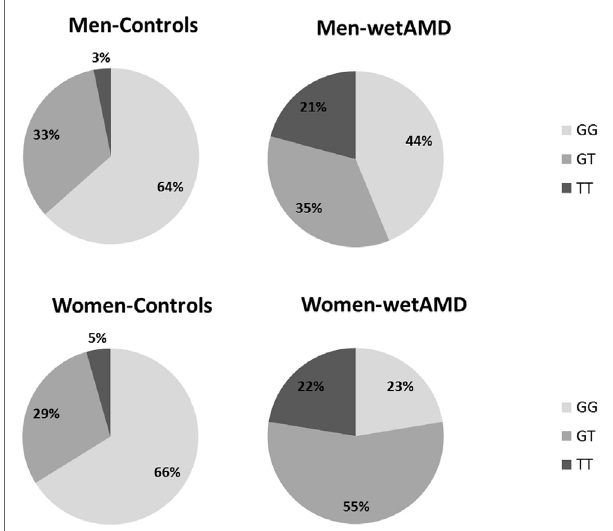
FigUre 1 | Percentage of individuals according to C-reactive protein (CRP) level stratification divided by gender (men: upper row; women: lower row) and study groups (controls: left column and wet age-related macular degeneration: right column). L-CRP (low C-reactive protein, < 1 mg/L; light gray), M-CRP (moderate C-reactive protein, 1.0–3.0 mg/L; medium gray), and H-CRP (high C-reactive protein, 3.0–10.0 mg/L; dark gray). Letters T and G: nucleotides for the ARMS2 A69S.